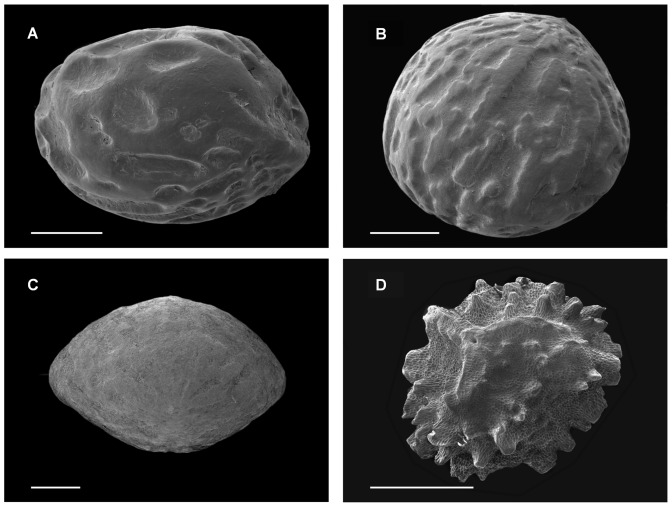
Four types of seed shape and sculpturing of Bornean Macaranga species (scale bar: 1 mm) – (a) M. hypolueca: spheroidal or slightly flattened with large shallow round pits (S), (b) M. bancanca: ovoid or subtriangular-ovoid with shallow grooves (O), (c) M. gigantea: lenticular with shallow grooves (L), and (d) M. winkleri: ovoid shape with coarsely verrucose surface (V).